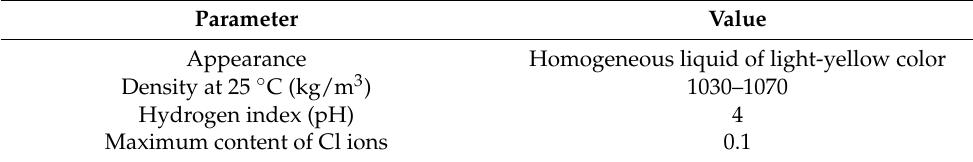
Table 1. Technical specifications of AR Premium AH